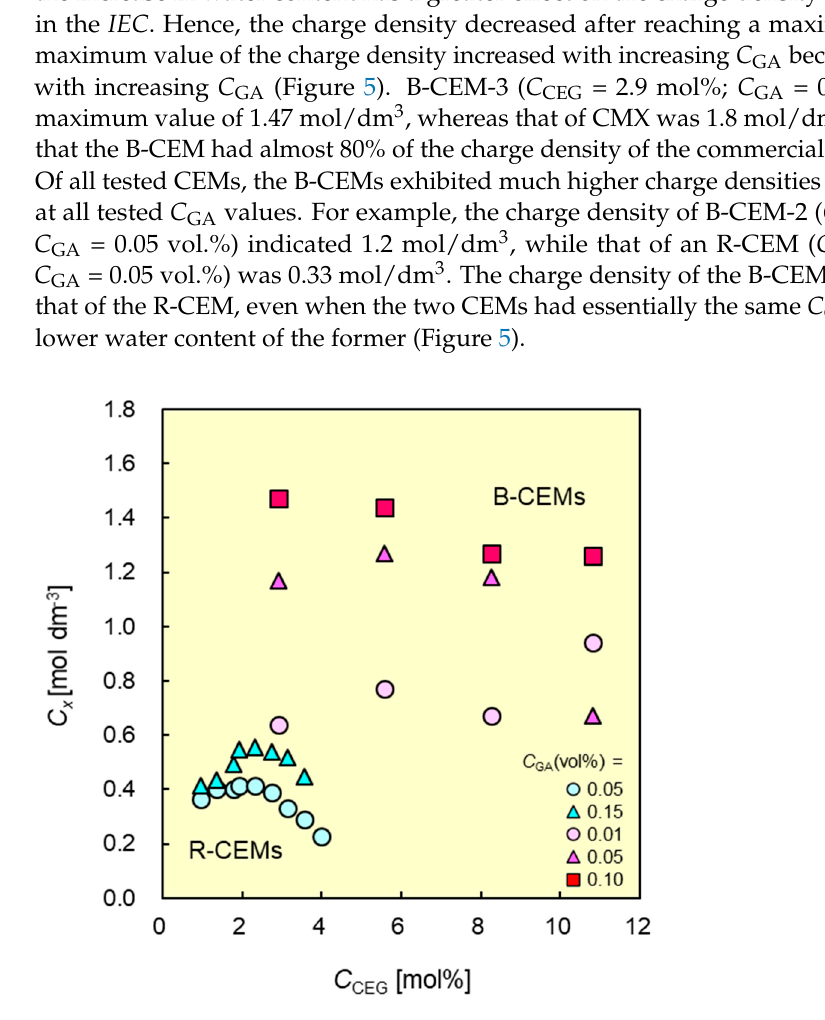
Figure 6. Charge densities C x of B-CEMs and R-CEMs as functions of contents C CEG of cation-exchange groups in copolymers. Red and blue symbols denote the data of B-CEMs and R-CEMs, re- spectively.